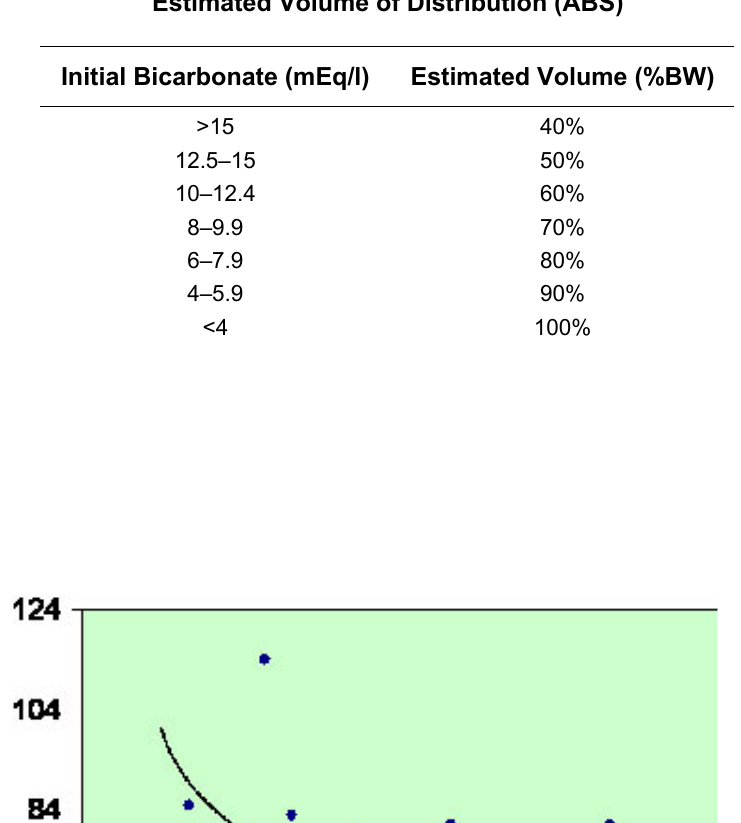
Estimated Volume of Distribution (ABS)